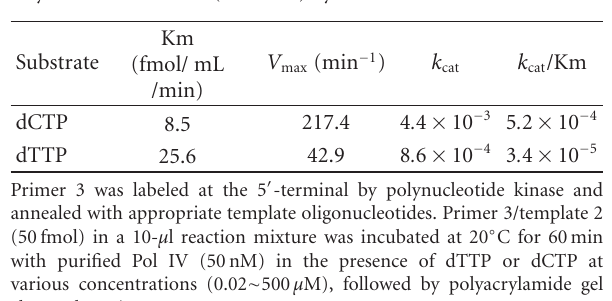
Table 2: The insertion kinetics of dCTP and dTTP opposite